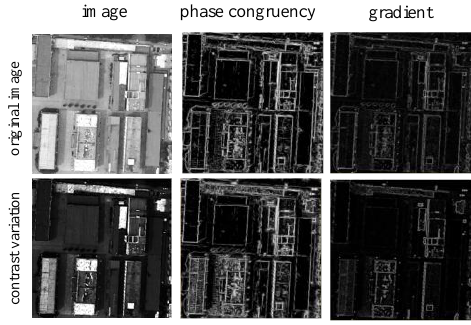
Figure 2. Comparison of phase congruency with gradient